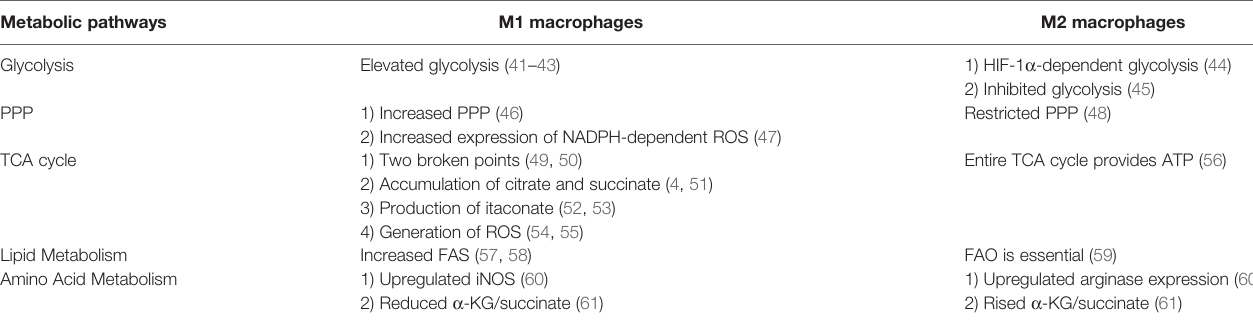
TABLE 1 | The main metabolic characteristics in M1 and M2